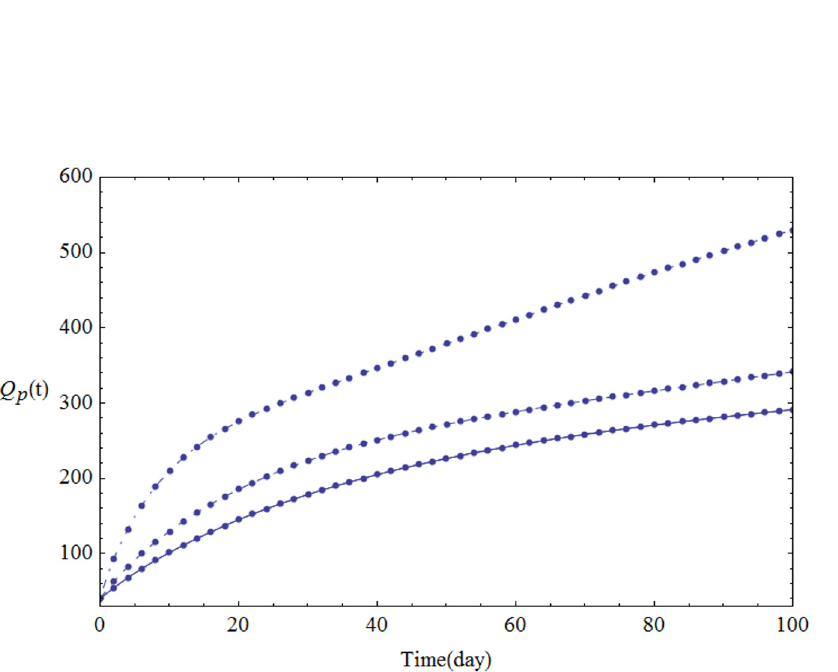
Fig 5. The population of Q t ( t ) versus t: α = 1.0 (solid line), α = 0.95 (dashed line) and α = 0.85 (dot- dashed line).